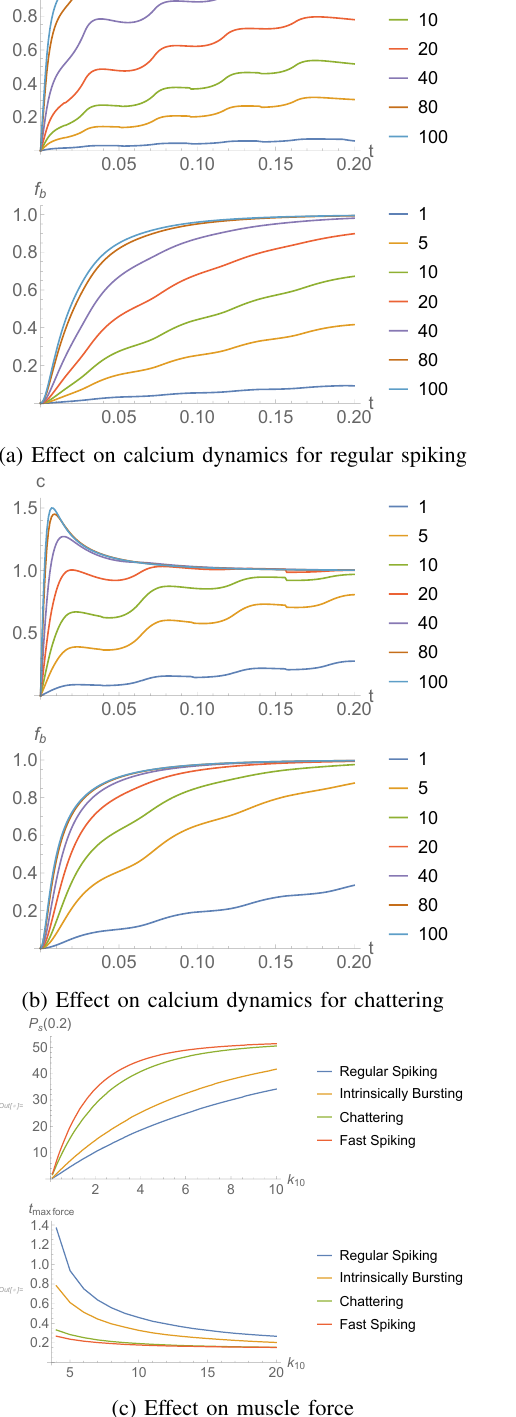
Fig. 5: Effect of varying the parameter k 10 .